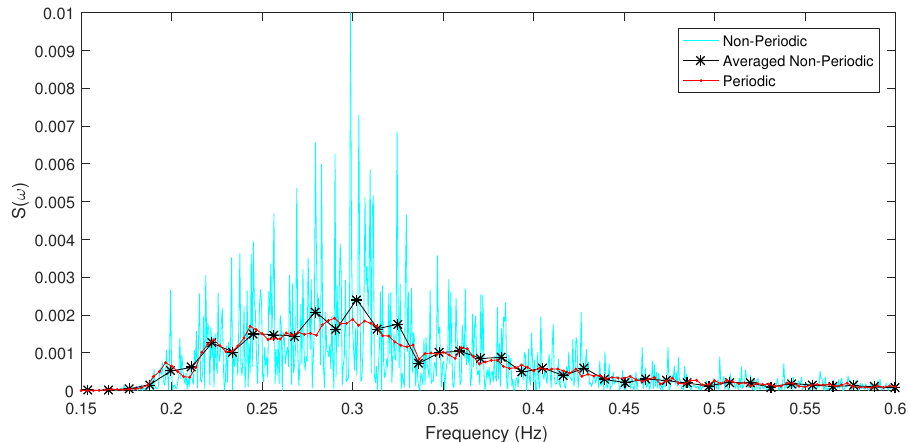
Figure 3. Comparison of Bretschneider spectra from periodic and non-periodic experiments.